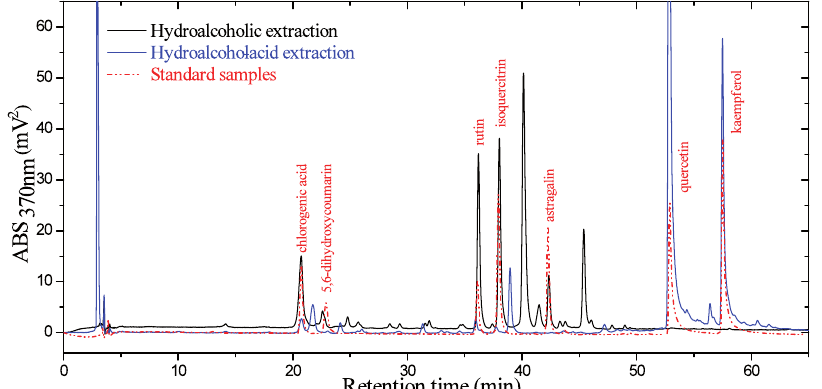
Fig. 1: HPLC chromatogram of hydroalcoholic (black line) and hydroalcohol-acid (blue line) extracts. Hydroalcoholic Extraction: extracted by ethanol-water (V/V: 7/3) solution. Hydroalcohol-acid Extraction: extracted by ethanol-HCL-water (V/V/V: 7/2/1) solution